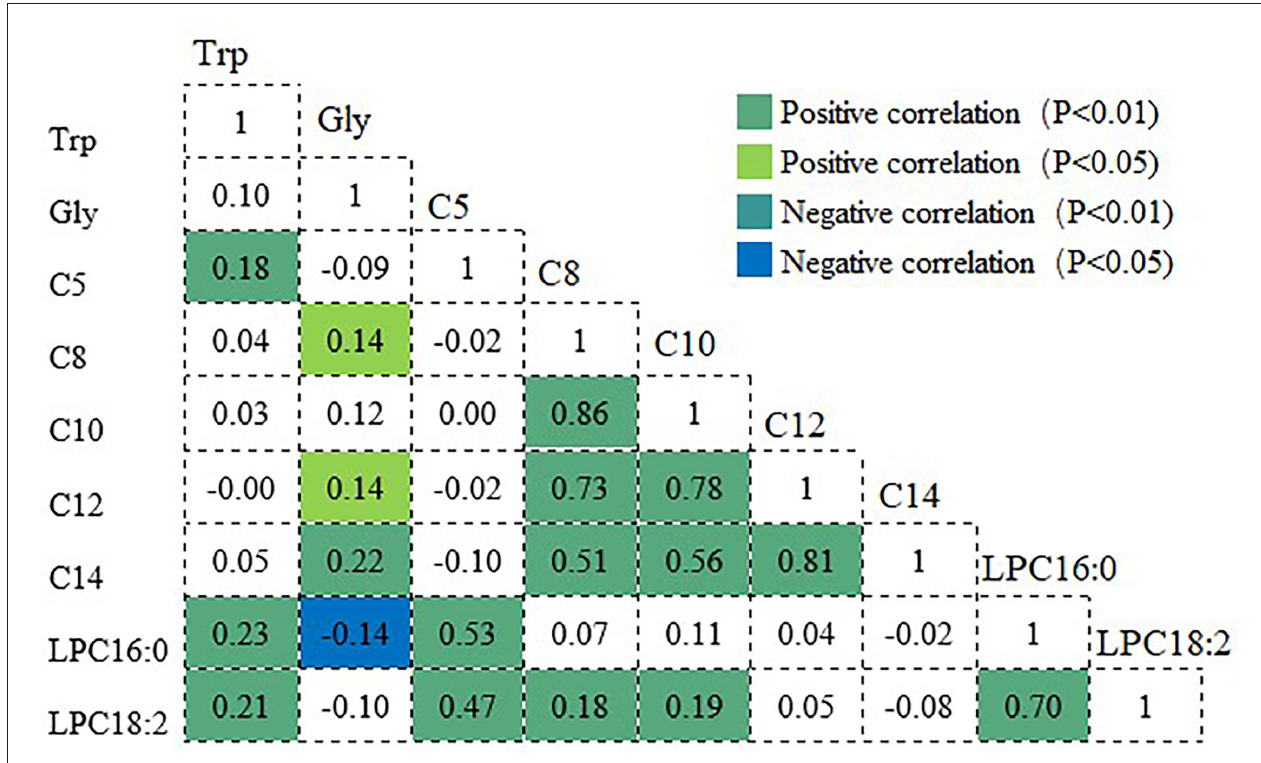
FIGURE 1 | Correlation coefficients among the metabolites significantly associated with frailty. Positive and negative correlations are shown in green and blue, respectively. Trp, tryptophan; Gly, glycine; C5, valeryl-L-carnitine; C8, octanoyl-L-carnitine; C10, decanoyl-L-carnitin; C12, dodecanoy-L-carnitine; C14, tetradecanoyl-L-car-nitine; LPC16:0, 1-palmitoyl-2-hydroxy-sn-glycero-3-phosphocholine; LPC18:2,